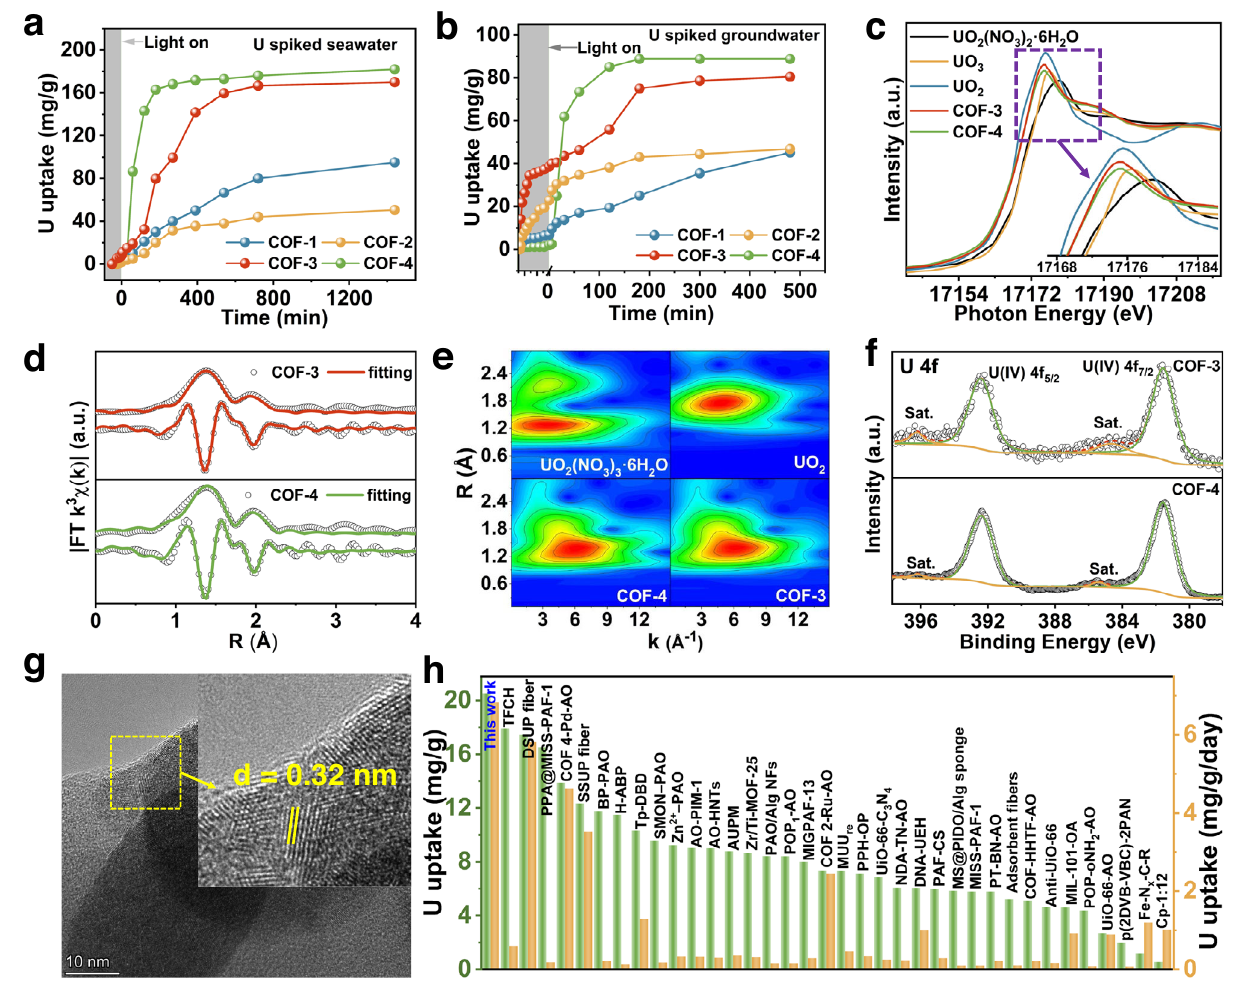
Fig. 4 | Photocatalytic uranium extraction performance. a Uranium extraction fromspiked seawaterwithinitialuranium concentrationsof ~20ppm,using COF-1, COF-2, COF-3, and COF-4 as photocatalysts. b Uranium extraction from spiked groundwater with initial uranium concentrations of ~10 ppm, using COF-1, COF-2, COF-3, and COF-4 as photocatalysts. c U L III -edge XANES spectra for COF-3 and COF-4 after uranium extraction studies. UO 2 (NO 3 ) 2 ·6H 2 O, UO 2 , and UO 3